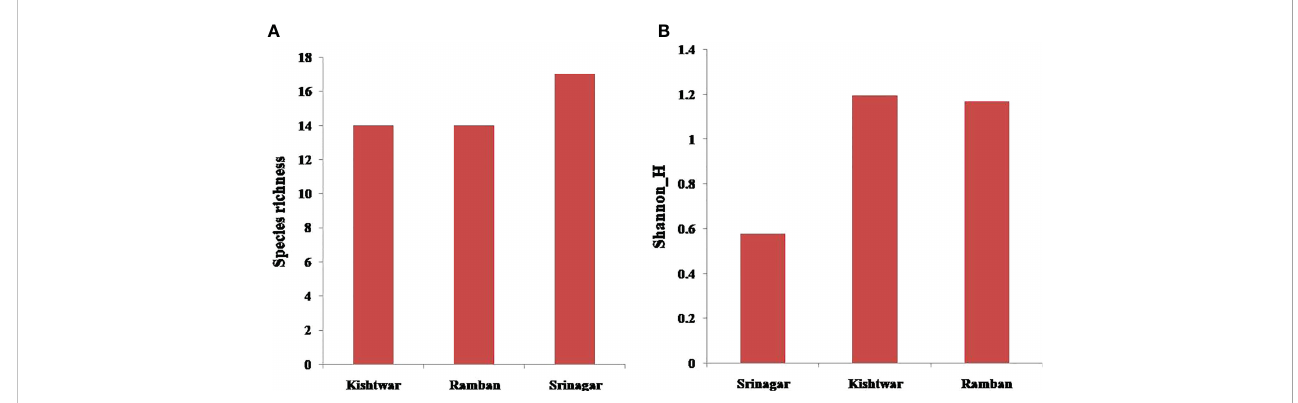
FIGURE 6 (A) Species richness across the three locations (Srinagar, Kishtwar and Ramban). (B) Shannon ’ s (H ′ ) index across the three locations (Srinagar, Kishtwar, and Ramban).